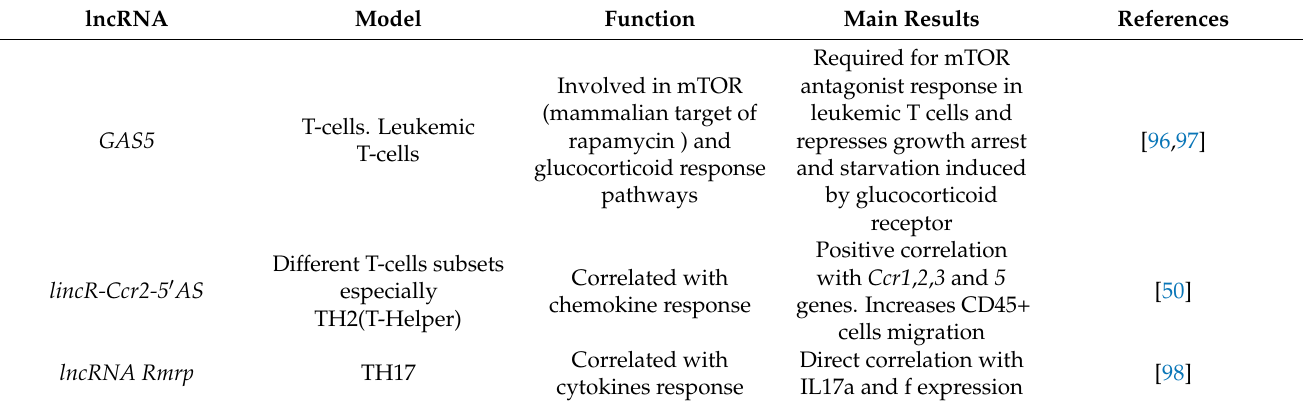
Table 2. LncRNAs role and mechanisms in adaptive